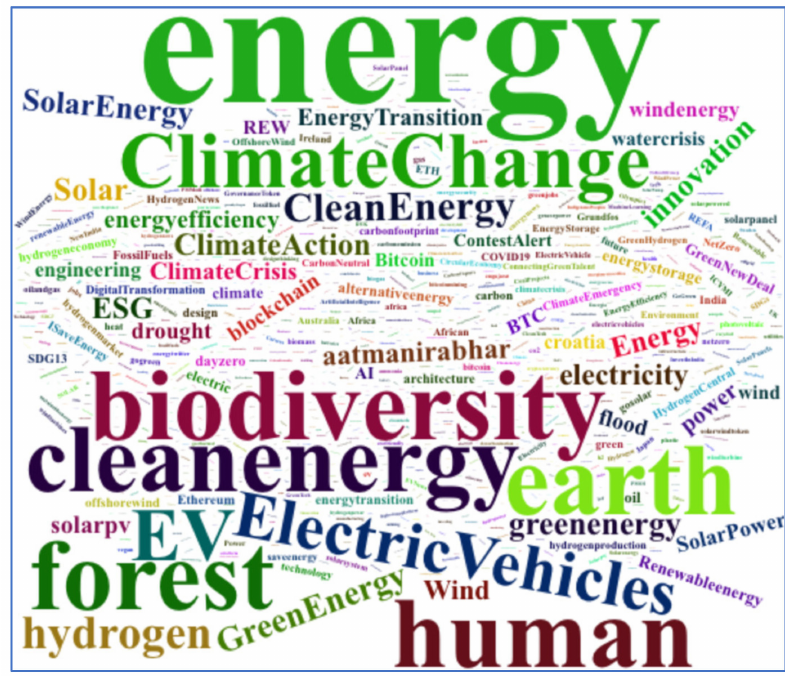
Figure 10. WordCloud of Twitter hashtags.